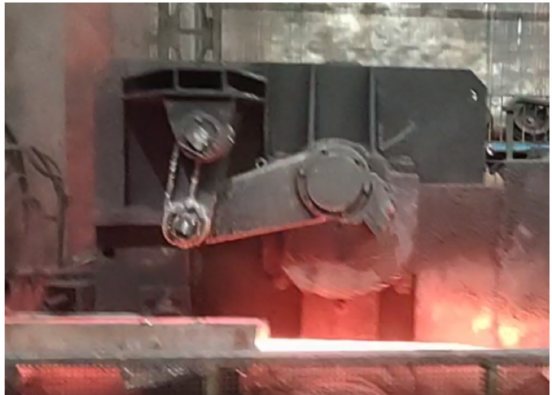
Figure 6. Schematic of the cut end of a composite